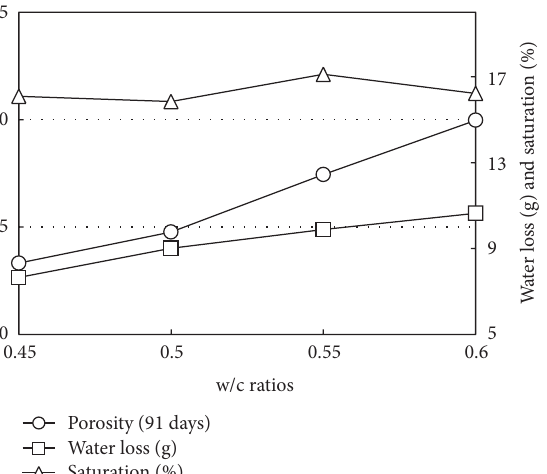
Figure 8: Sorptivity, surface concentration, moisture diffusion, and porosity with different W/C